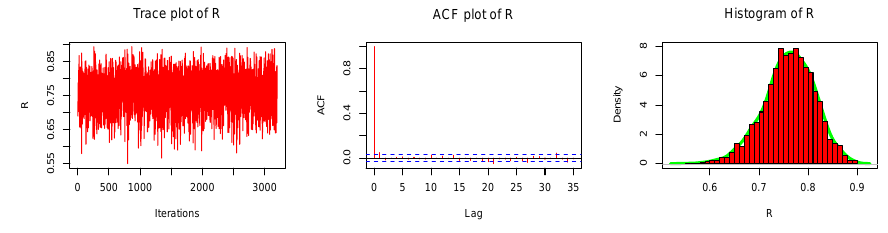
Figure 4 – The trace, ACF and histogram with Gaussian density plots of the generated chain for parameter R corresponding to censoring scheme ( CS